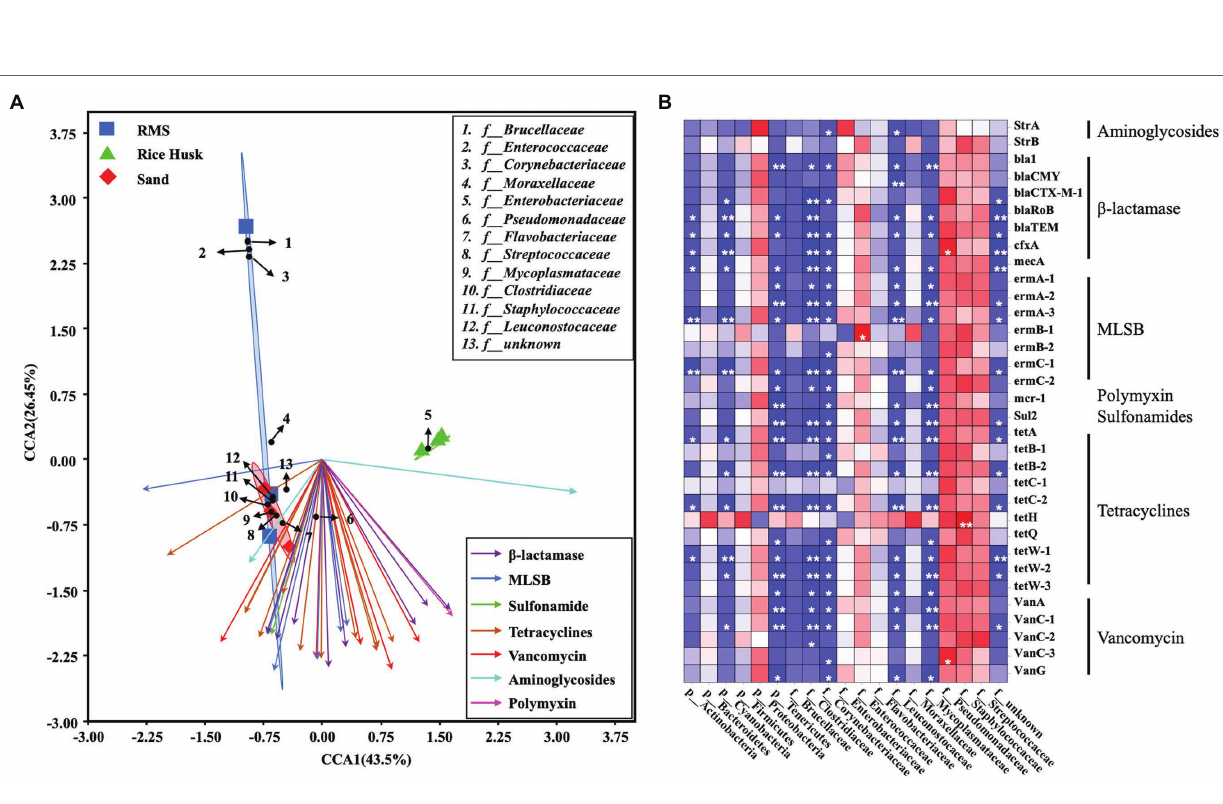
FIGURE 3 | Combined analysis of ARGs and bacterial communities in milk. (A) Canonical correspondence analysis (CCA) of ARGs and bacterial family communities in milk. (B) Spearman correlation analysis between ARGs and milk bacteria at the phylum and family levels. Red squares: positive correlation; blue squares: negative correlation; * p < 0.05; ** p < 0.01; and *** p ≤ 0.001.